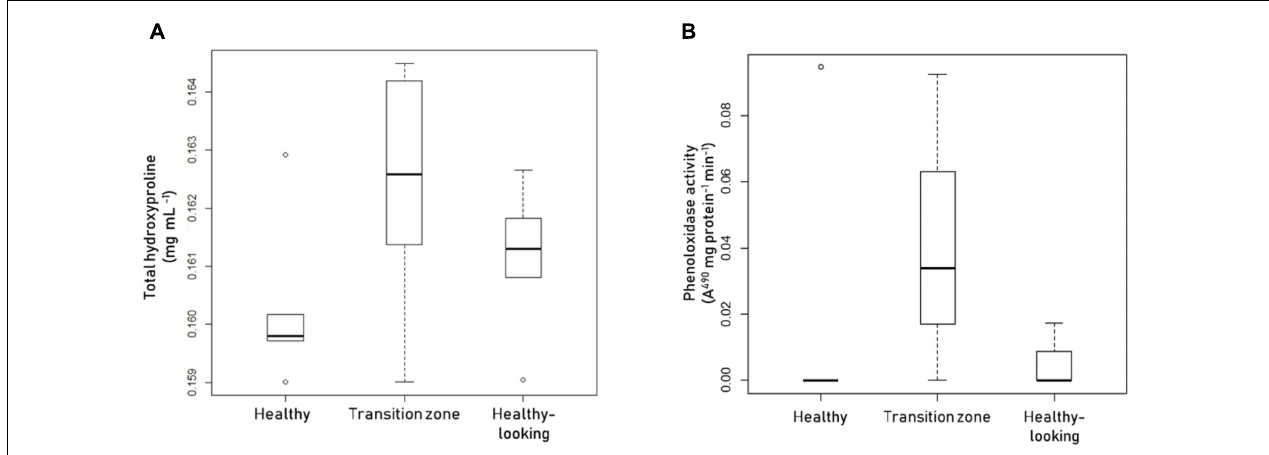
FIGURE 1 | Assessment of the immunological response of the mucus complex in coral colonies. Boxplots showing (A) total hydroxyproline or (B) phenoloxidase activity levels in mucus samples collected from healthy Pseudodiploria strigosa colonies (left), and colonies affected by black band disease, collected above the transition zone (center), or above healthy-looking tissues (right). Dots represent atypical data. Data from 5 independent determinations, with three technical replicates